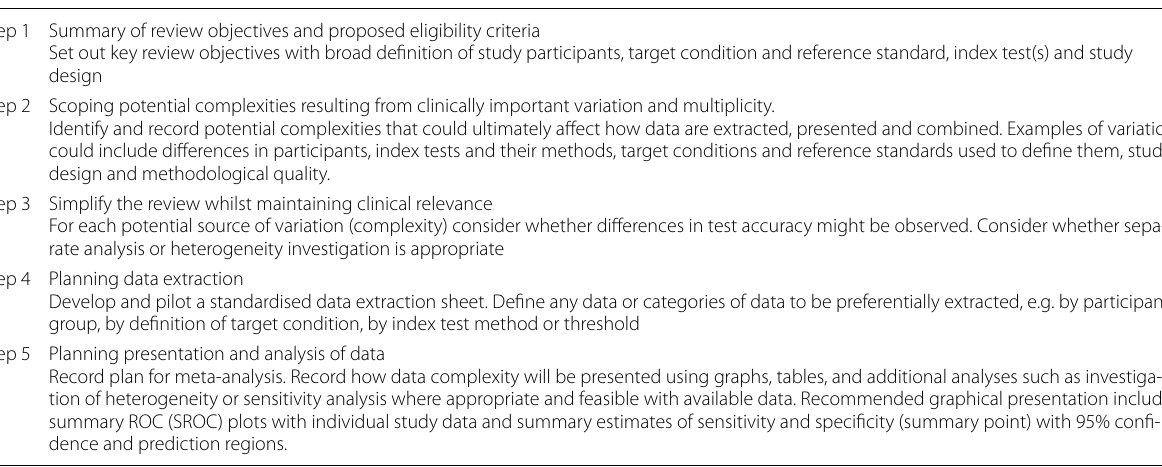
Table 1 Summary of TOMAS-R